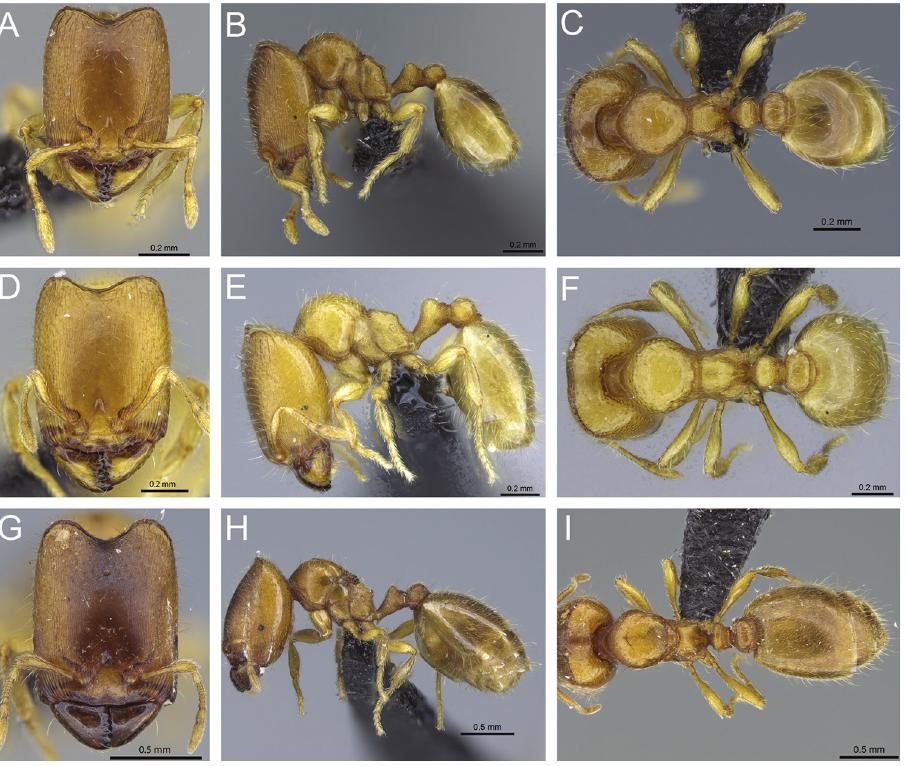
Figure 48. Intermediates of Carebara lova . Major workers, CASENT0470797: A head in full-face view B body in profile view C body in dorsal view. CASENT0036019: D head in full-face view E body in profile view F body in dorsal view. CASENT0035922: G head in full-face view H body in profile view I body in dorsal